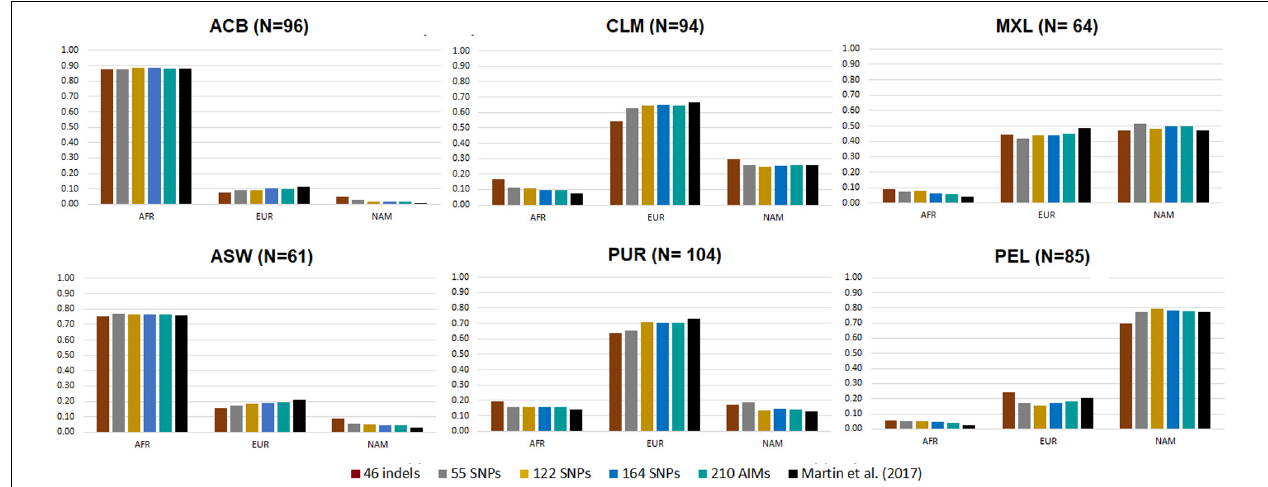
FIGURE 5 | Average ancestry proportions for the five AIM panels in six American admixed populations from the 1000 Genomes database. Reference values based on genome-wide SNP data are represented in black (Martin et al., 2017).